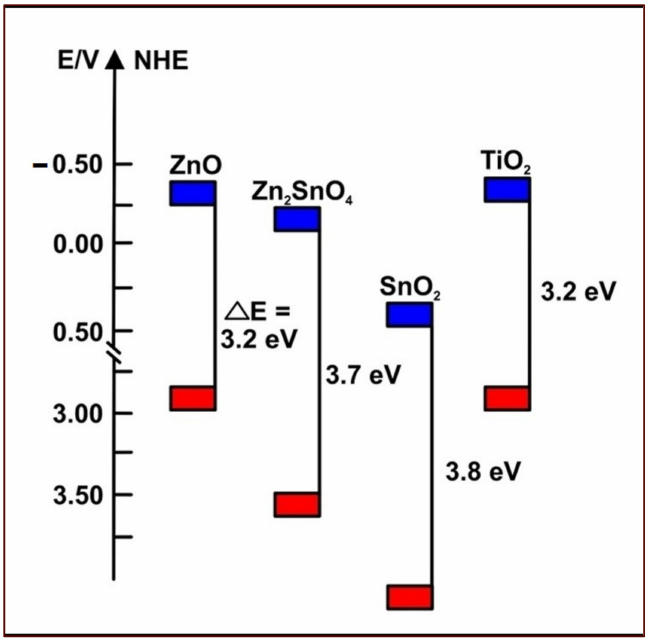
Figure 2. The energy band positions of commonly used semiconductors indicate ZnO as a promising alternative to TiO 2, given their matching energy band structures. Modified after reference